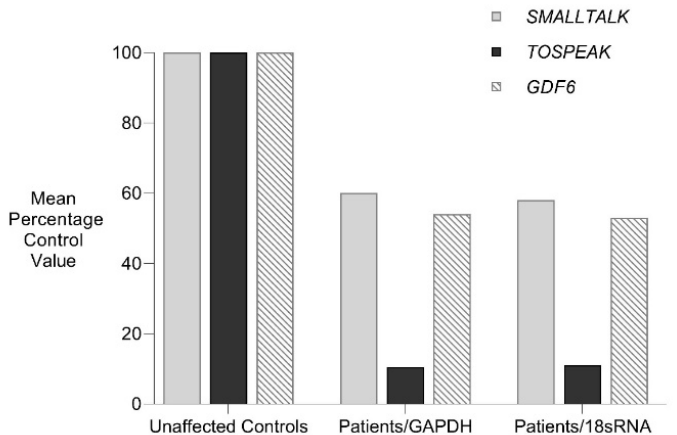
Figure 3. TOSPEAK gene characterisation: ( A ) Comparative genomic analysis of the TOSPEAK locus ( i ) Schematic view of the genomic region spanning inv(8) (q22.2q23.3) breakpoints in the SYNS4 family with congenital carpal tarsal coalition and progressive postnatal ossification and fusion of vertebral and ear joints. Genes (horizontal arrows), GDF6 enhancers (vertical arrows). ( ii ) TOSPEAK / C8orf37-AS1 gene structure with 8q22.2 breakpoint in the 4th intron. ( iii ) VISTA plot spanning TOSPEAK gene (exons marked blue) for multiple vertebrate species where strict selection criteria applied for highly conserved regions (HCRs ≥ 200 bp ungapped alignment with > 90% identity). The human gene annotation was obtained from the Ensembl database and the repeat information was obtained from Repeat Masker (6 September 2009)). ( B ) Overlap between the TOSPEAK and SMALLTALK/C8orf37 genes. ( C ) Northern Analysis of TOSPEAK in human tissues.